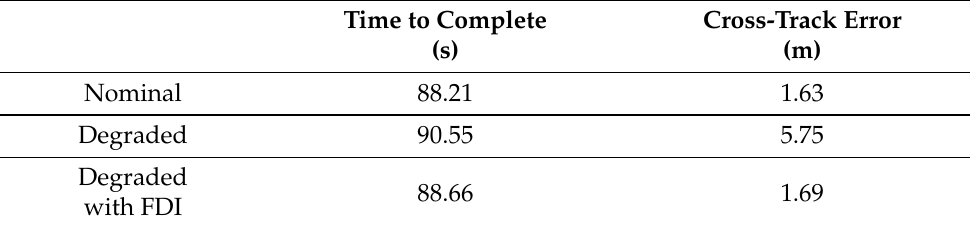
Table 6. Waypoint scenario